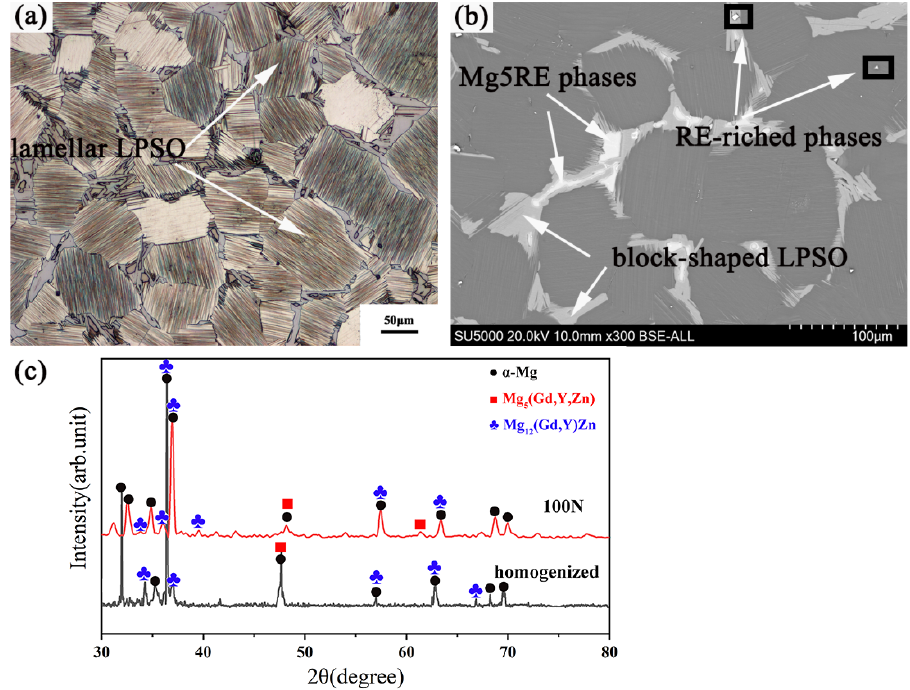
Figure 2. ( a ) The OM image of the as-homogenized Mg-12Gd-4Y-2Zn-0.5Zr alloy, ( b ) the SEM image of the Mg-12Gd-4Y-2Zn-0.5Zr alloy, ( c ) X-ray diffraction (XRD) pattern of the initial alloy and the RBEed sample after 100 N.